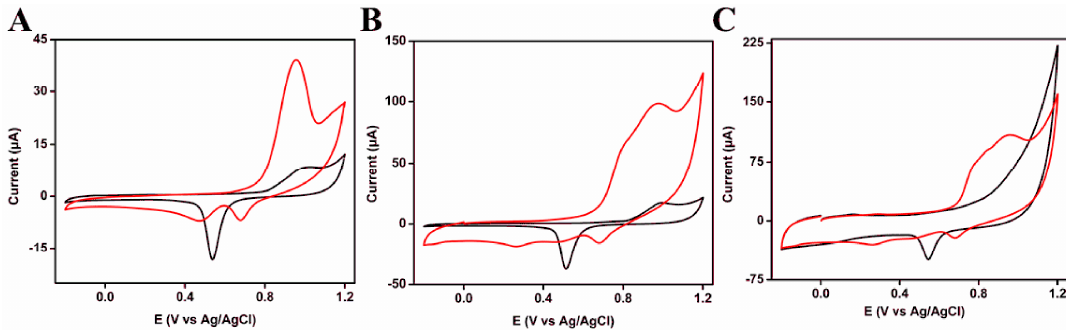
Figure 2. CVs of 1 mM VAN (red) in 0.1 M H 2 SO 4 and the blank (0.1 M H 2 SO 4 ) (black) solutions at AuNP–C–SPE ( A ), at AuNS–C–SPE (electrogenerated) ( B ), and at AuNS–G–SPE ( C ); Scan rate 0.1 V·s − 1 .